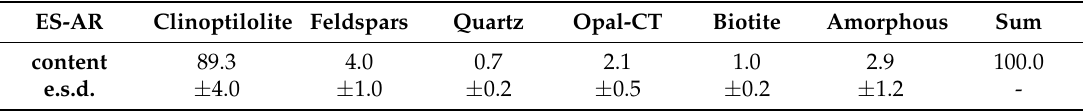
Table 1. Mineralogical composition of sample ES-AR (values in wt %; e.s.d. = estimated standard deviation; R-weighted pattern (Rwp) =